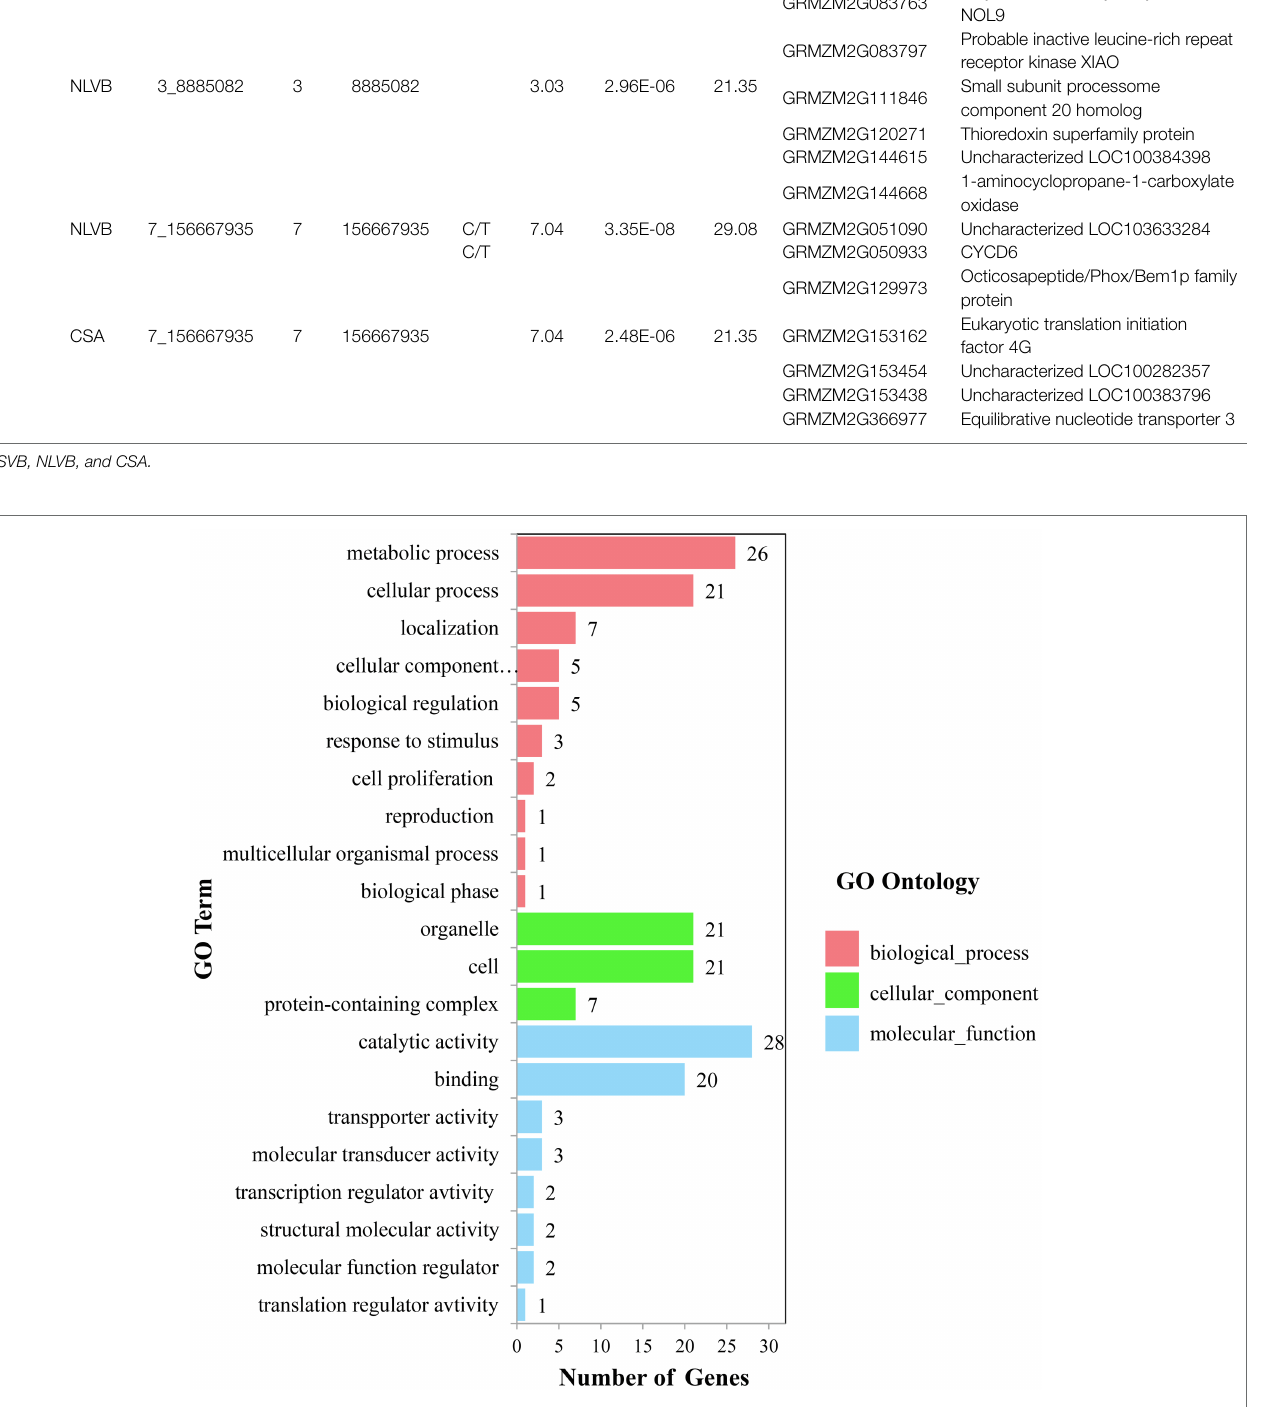
FIGURE 5 | GO-second class of candidate gene.